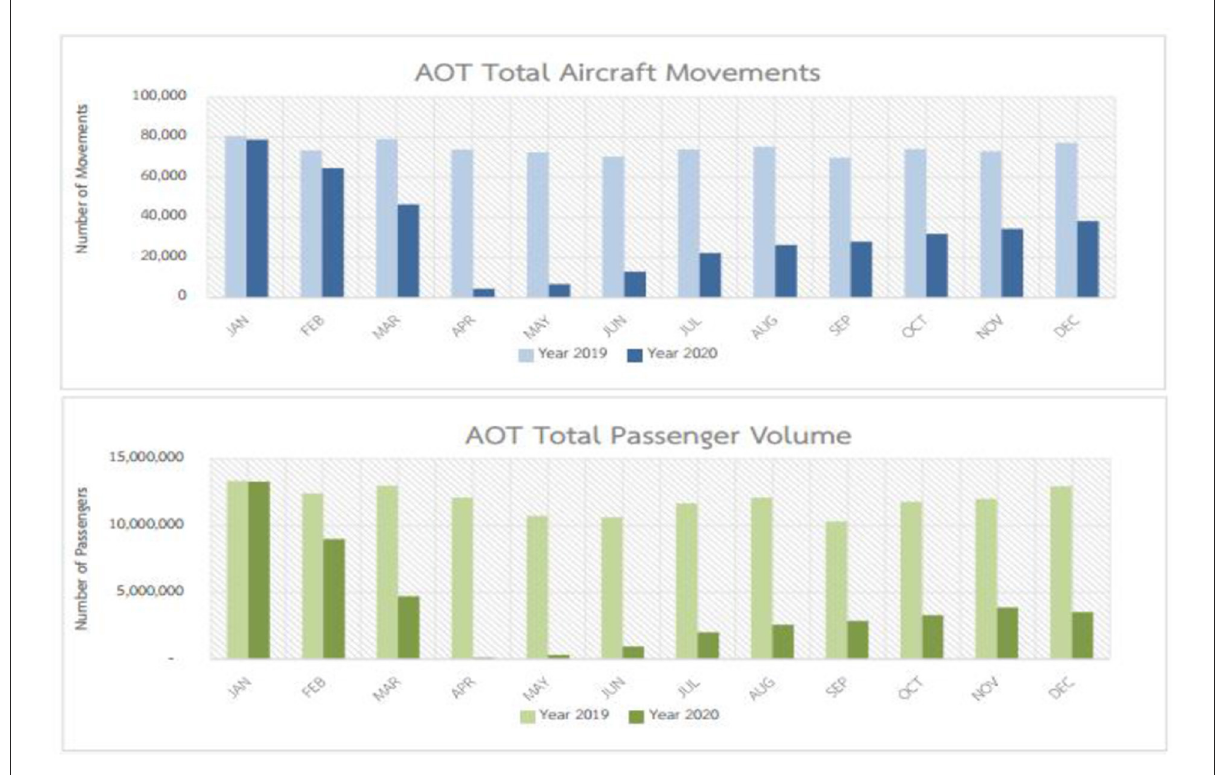
FIGURE1 Comparative position of aircraft movement and passenger volume